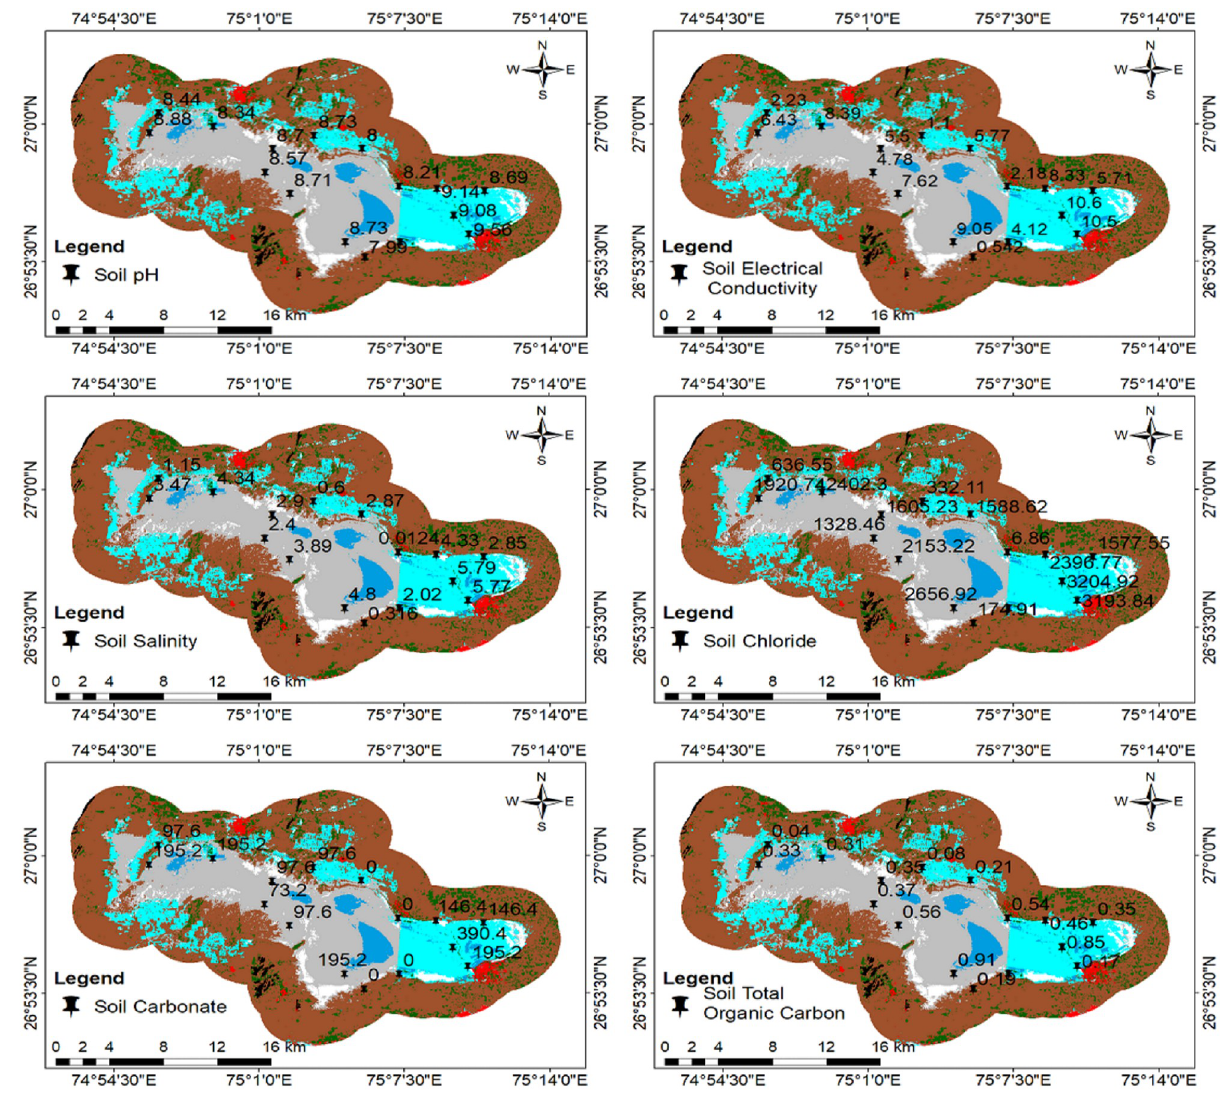
Fig 7. Mapping soil quality parameters.